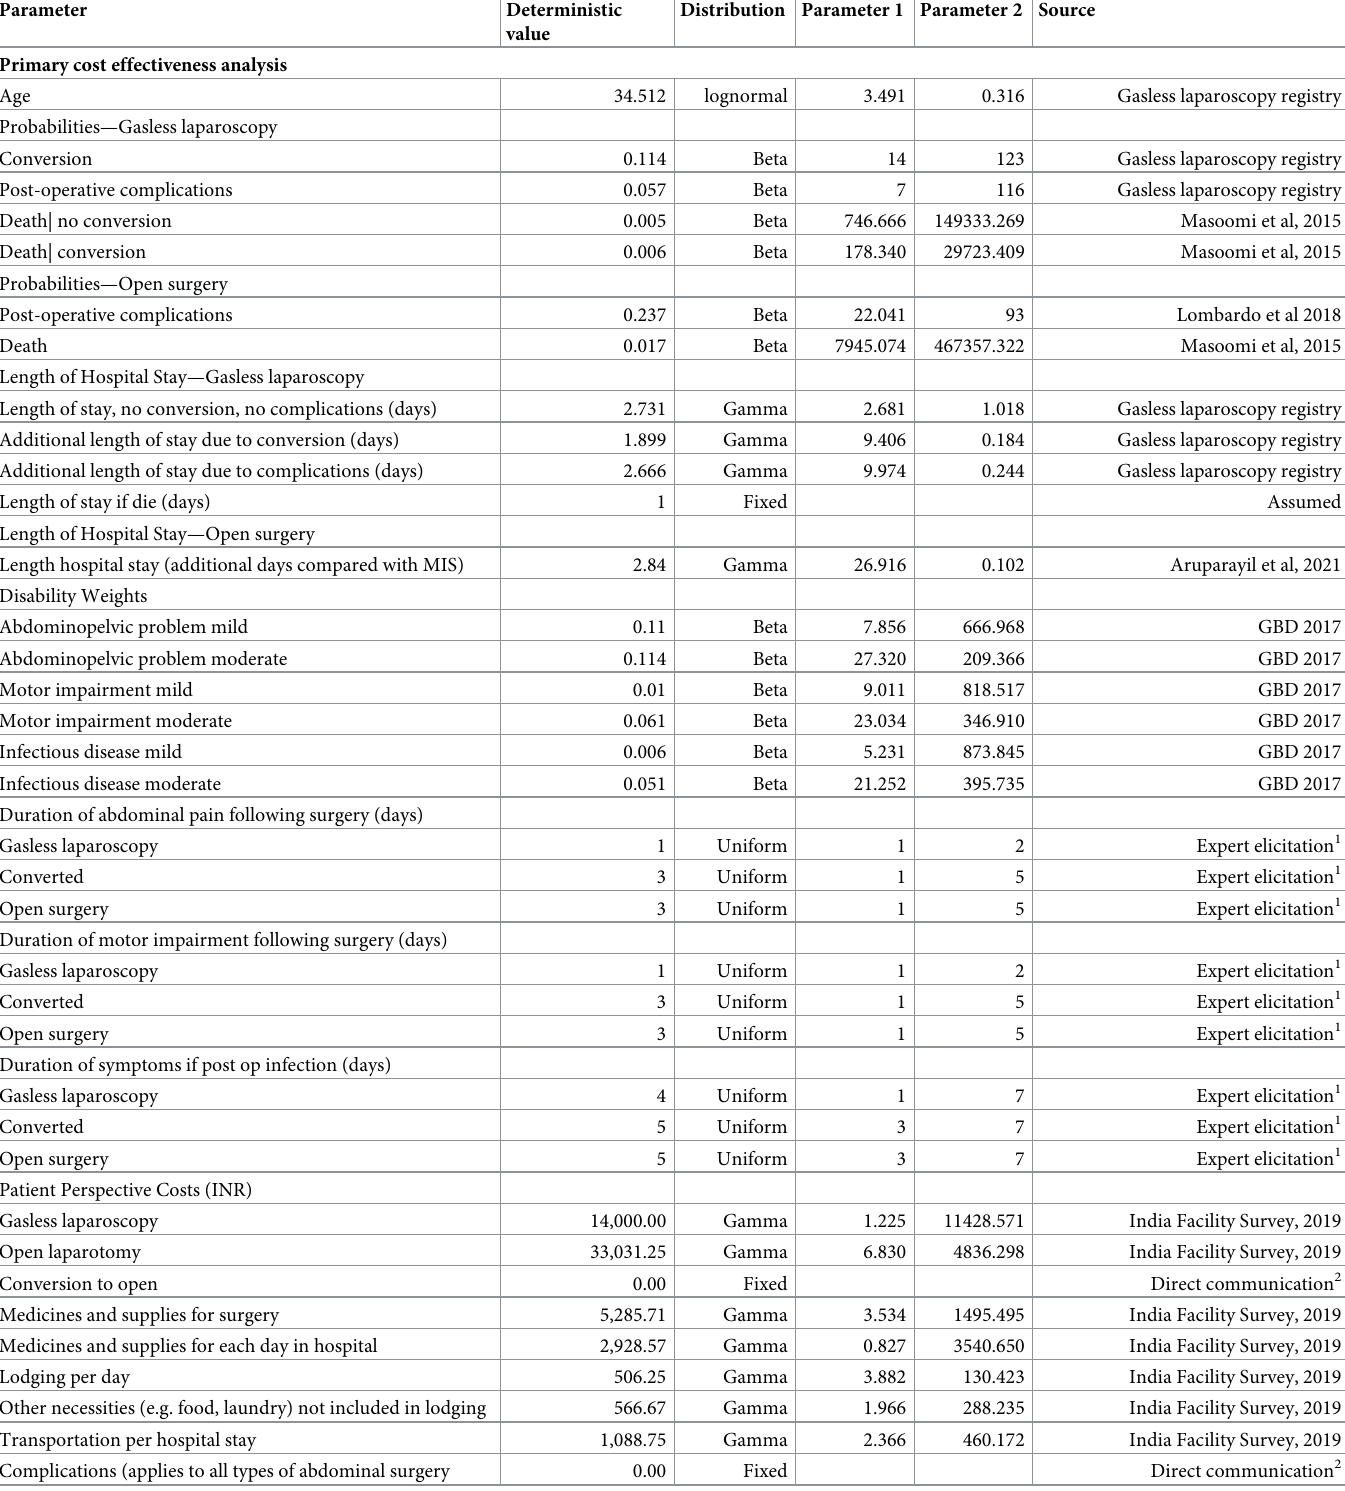
Table 1. Parameter